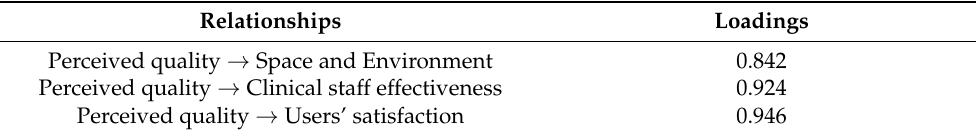
Table 8. Direct effects on the final model.